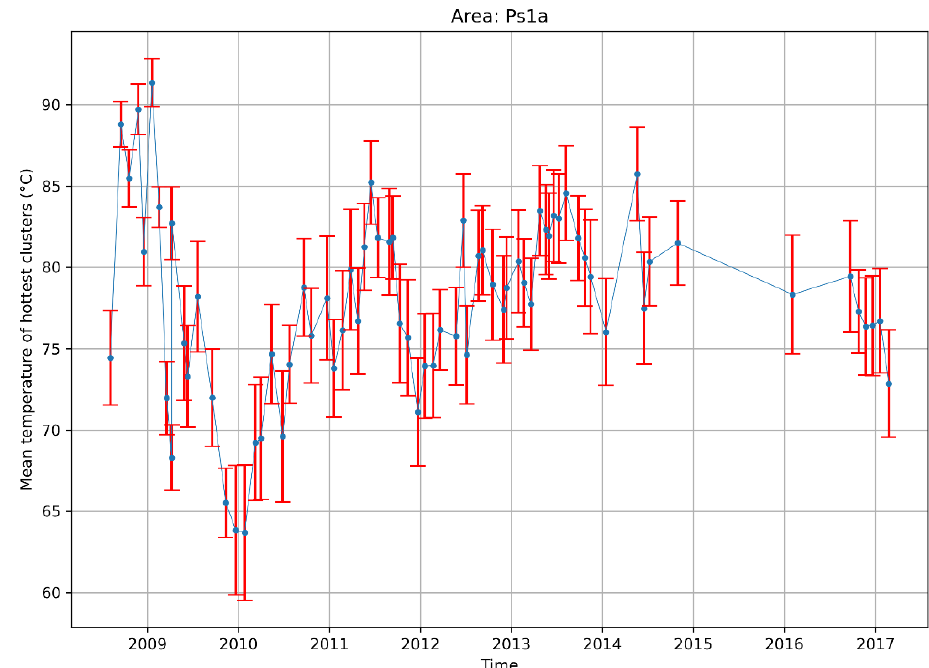
Figure 12. Weighted average temperature trend of the three hottest clusters with their related standard deviation of thermal images taken in the Pisciarelli area (Campi Flegrei), indicated as “Ps1a” in Figure 1, acquired between 2008 and 2017.